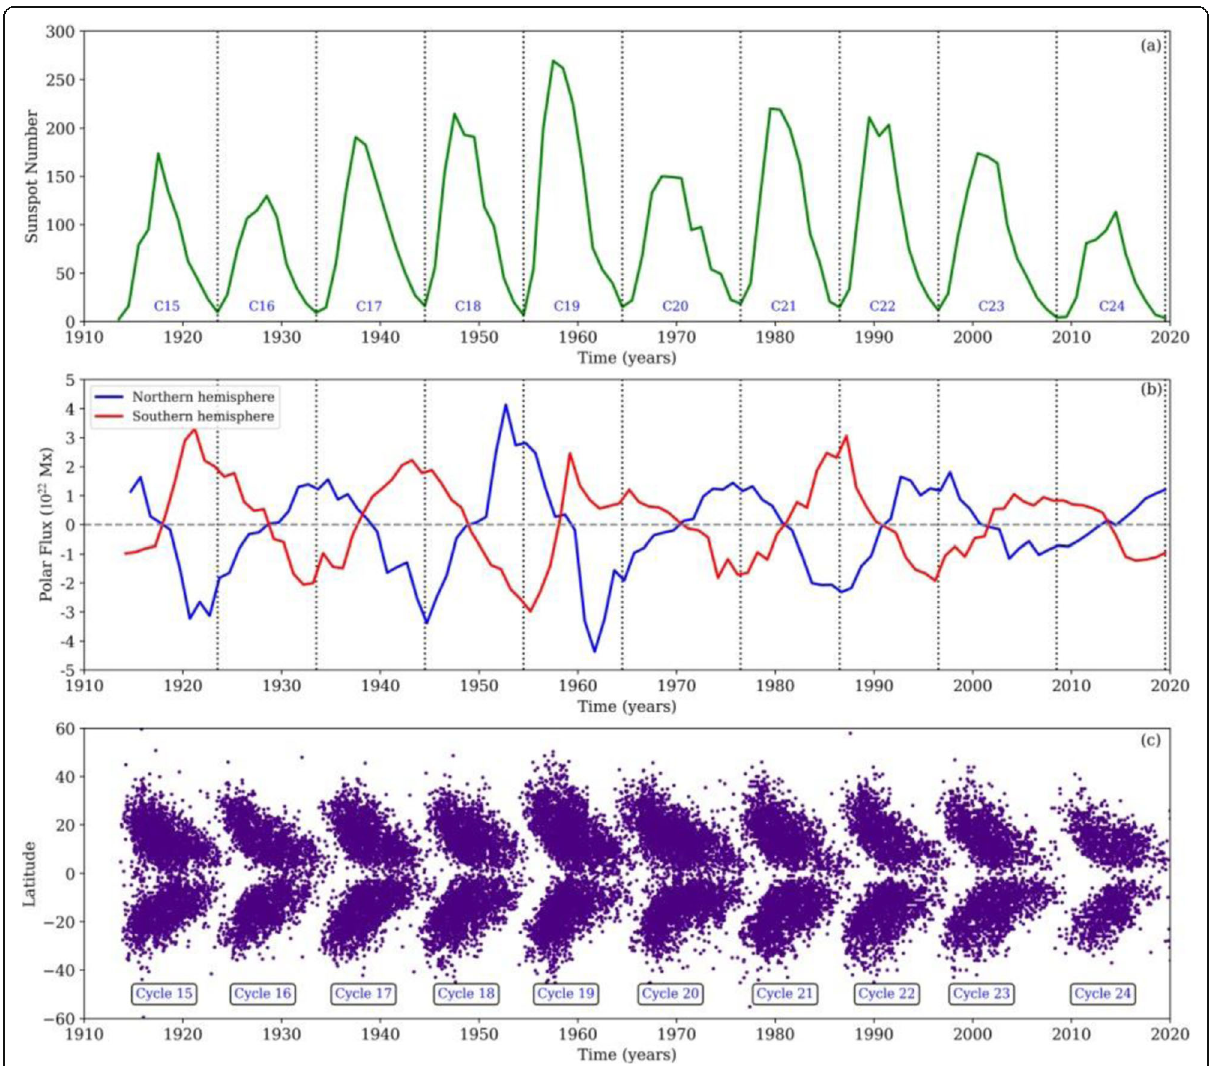
Fig. 4 Constraints on the solar magnetic cycle based on observations over the past century. The top panel depicts the quasi-periodic variation of sunspot numbers, the middle panel depicts the variation of the polar field in the northern and southern hemispheres gleaned from polar faculae counts (Muñoz-Jaramillo et al. 2013) and polar field observations and the bottom panel depicts the sunspot butterfly diagram, i.e., the spatio- temporal evolution of latitudes where sunspots appear. Theoretical dynamo models aspire to reproduce these observational constraints, while solar cycle prediction efforts focus on forecasting the strength of future solar